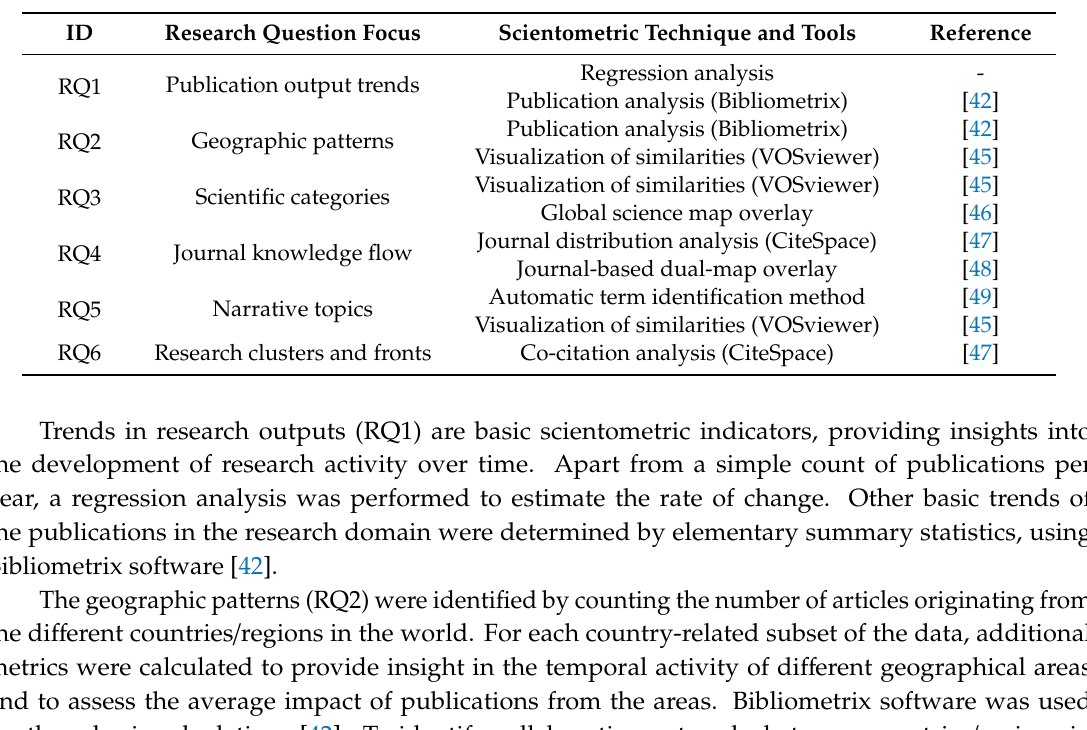
Table 2. Overview of scientometric techniques and tools used to answer the research